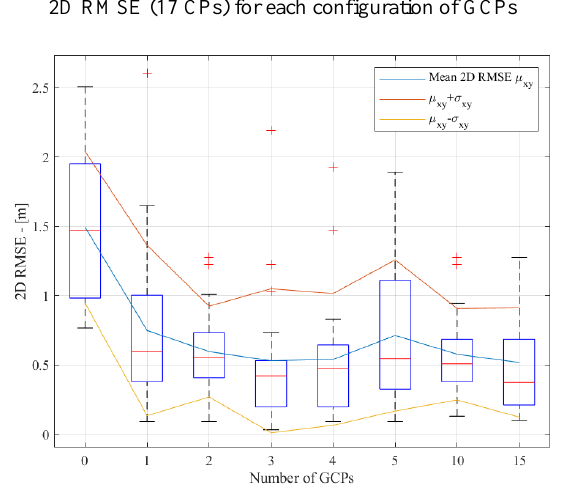
Figure 9 – Orthoimagery (satellite DSM) planimetric accuracy: 2D RMSE (17 CPs) for each configuration of GCPs